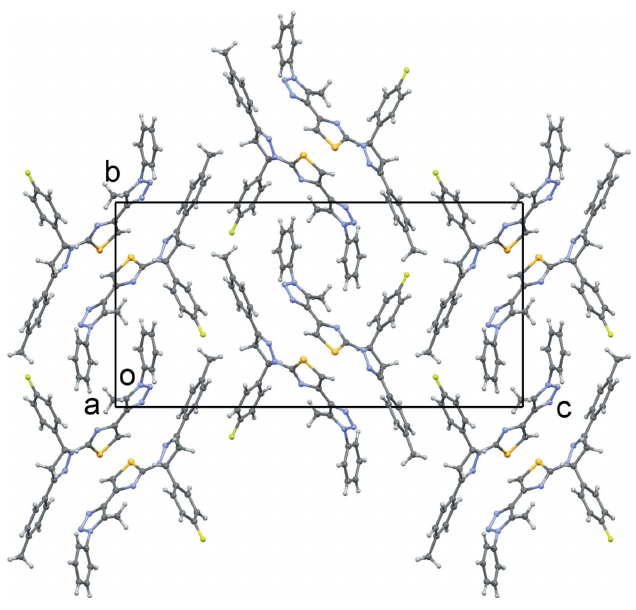
Figure 2 The crystal structure viewed down the a -axis